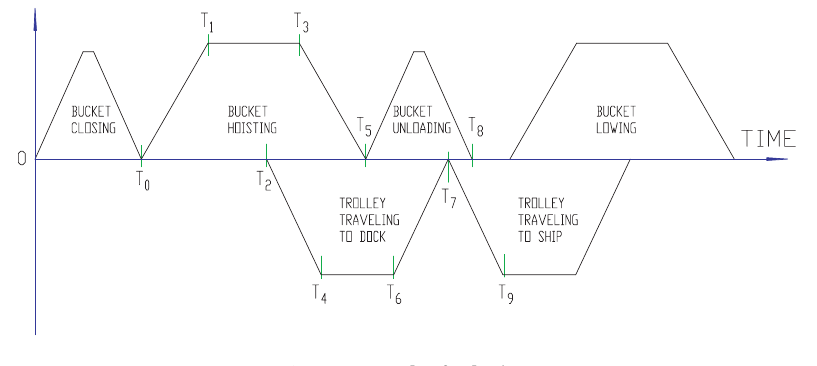
Fig. 1. Duty cycle of unloader.